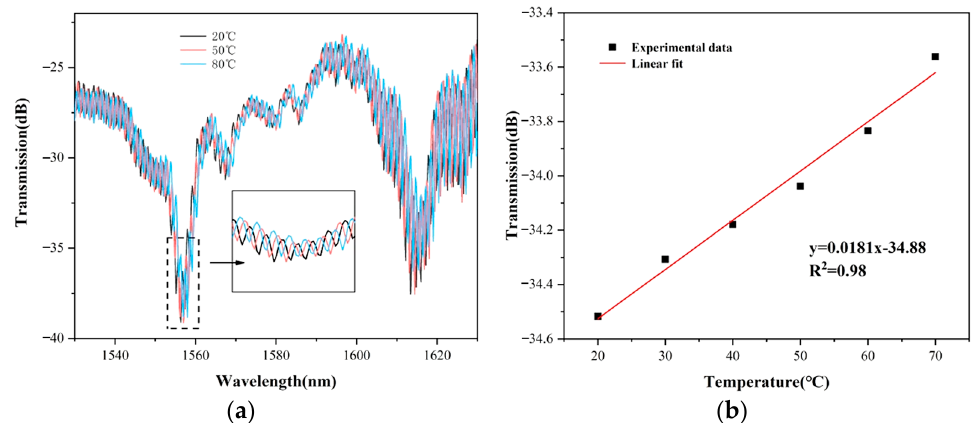
Figure 11. ( a ) The variation of the transmission spectrum with temperature increasing from 20 °C to 80 °C; ( b ) The linear fit of the resonant wavelength about the sensitivity of 0.018 dB/°C.